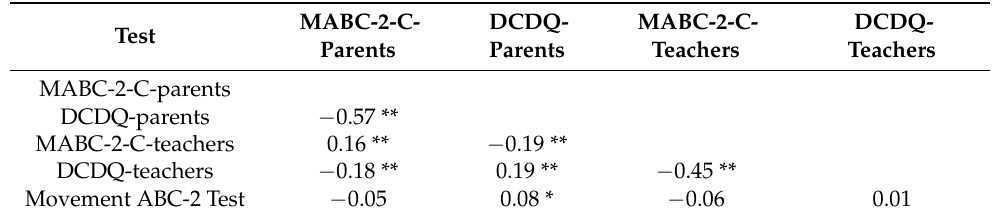
Table 7. Correlation of Movement ABC-2 Test and the MABC-2-C and DCDQ scores completed by parents and teachers of children without suspected DCD ( n =